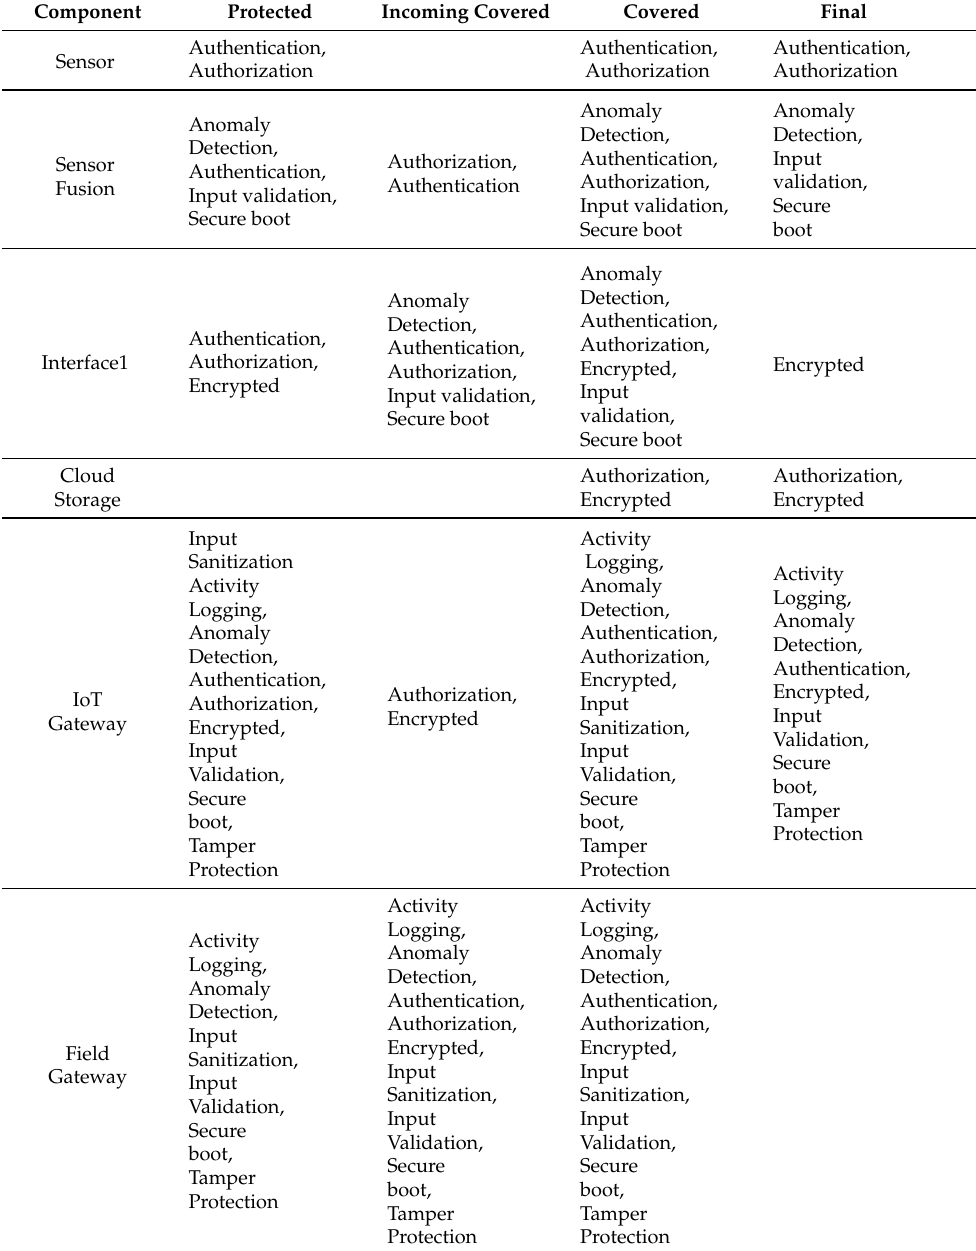
Table 5. Optimized security attributes in our proposed agriculture system